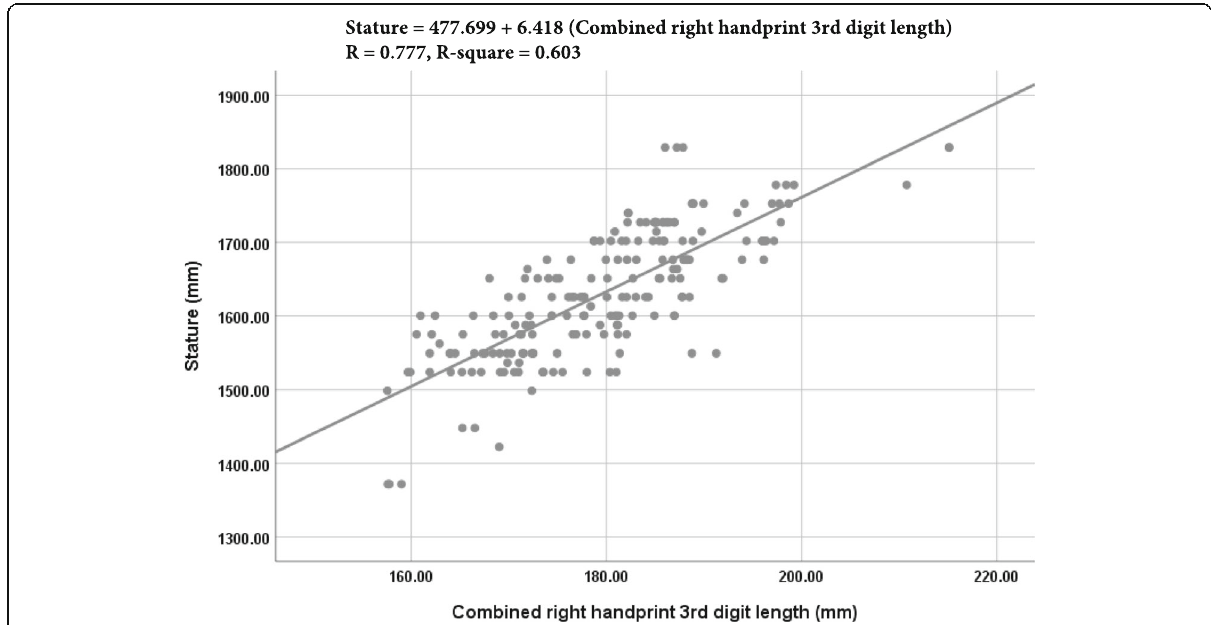
Fig. 5 Best fit curve to estimate stature from combined handprint 3 rd digit length